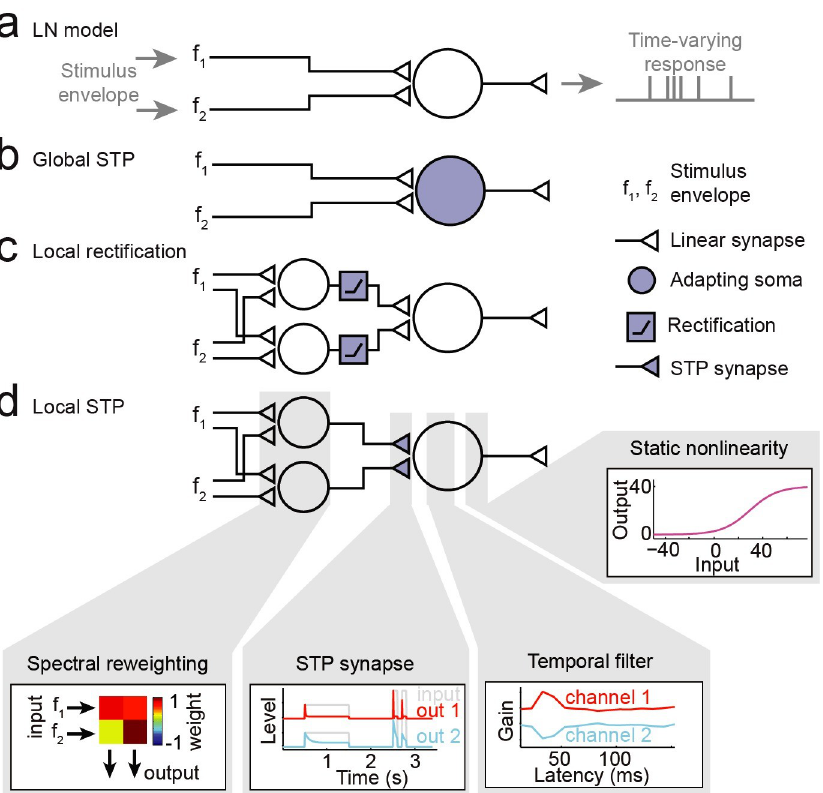
Fig 2. Alternative encoding models to describe auditory neural responses to vocalization-modulated noise. A. The linear-nonlinear spectro-temporal receptive field (LN model) describes the time-varying neural response as a linear weighted sum of the preceding stimulus envelopes, followed by a static sigmoid nonlinearity to account for spike threshold and saturation. B. In the global short-term plasticity (STP) model, nonlinear STP (depression or facilitation) is applied to the output of the linear filter prior to the static nonlinearity. C. In the local rectification model, the input channels are linearly reweighted and then nonlinearly thresholded (rectified) prior to the linear temporal filter and static nonlinearity. D. In the local STP model, input channels are linearly reweighted, and then nonlinear STP (depression or facilitation) is applied to each reweighted channel, prior to the linear temporal filter and static nonlinearity. Gray boxes show example model parameters applied at each processing